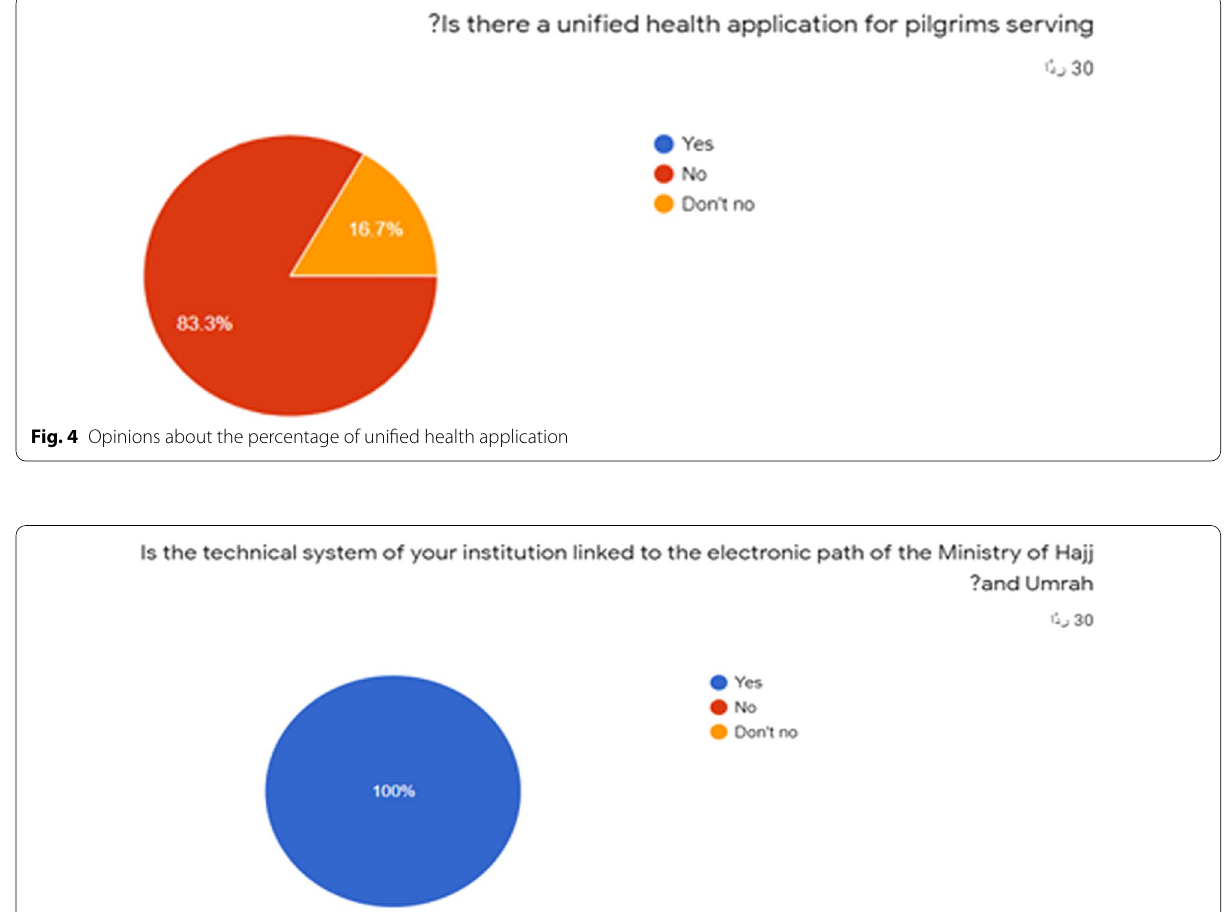
Fig. 5 Opinions about the linkage between institutions and the Ministry of Hajj and Umrah